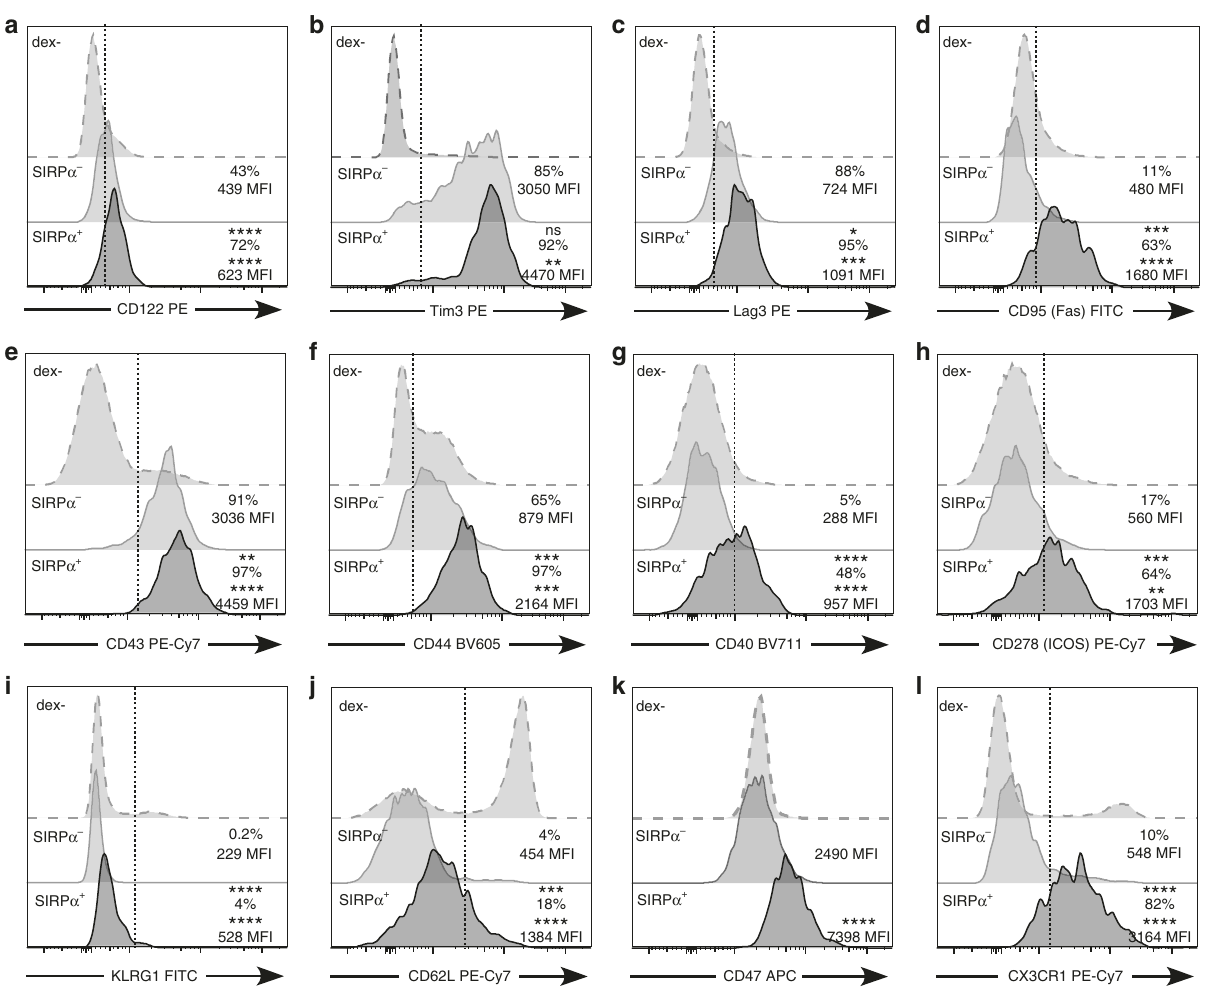
Fig. 3 Phenotype of Friend virus (FV)-speci fi c PD-1 + SIRP α − and PD-1 + SIRP α + CD8 + T cells in mice chronically infected with FV. Splenocytes from mice chronically infected with FV were analyzed by multiparameter fl ow cytometry for surface expression of ( a ) CD122, ( b ) Tim3, ( c ) Lag3, ( d ) CD95 (Fas), ( e ) CD43, ( f ) CD44, ( g ) CD40, ( h ) CD278 (inducible T cell co-stimulator), ( i ) KLRG1, ( j ) CD62L, ( k ) CD47, and ( l ) CX 3 CR1. A representative off-set histogram overlay is displayed for each marker as well as the average geometric mean fl uorescence intensity (MFI) from one experiment is given ( n = 4 mice). CD8 + dextramer − cells (non-DbgagL-speci fi c cells from infected mice) are shown in dashed gray, PD-1 + /SIRP α − CD8 + dextramer + cells are shown in solid line gray, and PD-1 + /SIRP α + CD8 + dextramer + are shown in black. The vertical dashed line delineates positivity relative to the FMO control). Results are from one of three independent experiments with similar results (with n = 8 additional mice). ns, p > 0.05, * p ≤ 0.05, ** p ≤ 0.01, *** p ≤ 0.001, **** p ≤ 0.0001 (unpaired, two-way t tests). The fl ow cytometric gating strategy is shown in supplementary Fig. 6h